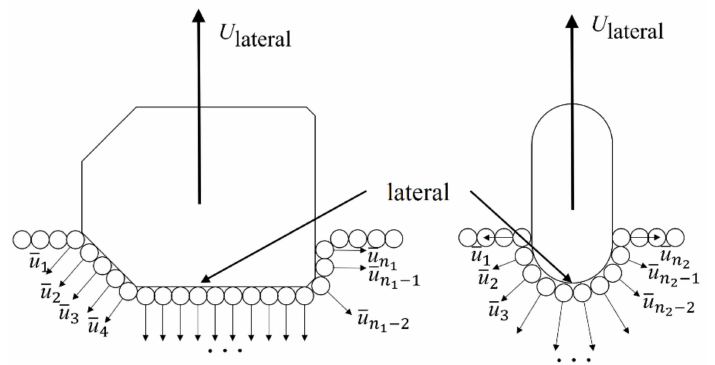
Figure 2. Instantaneous impulse Analysis when the side of corn seed touches soil.